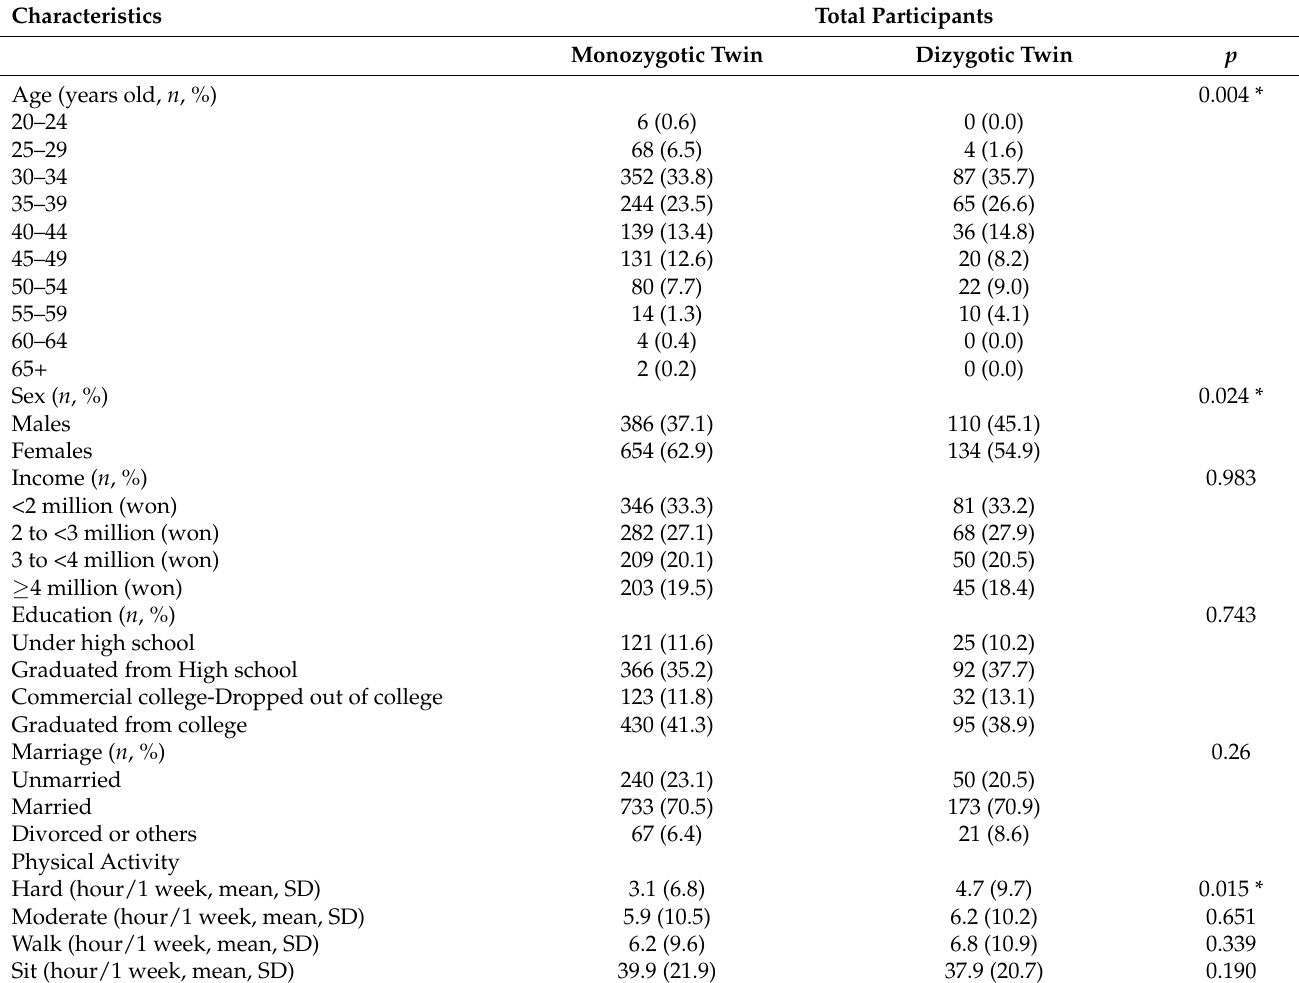
Table 1. Baseline characteristics of monozygotic and dizygotic